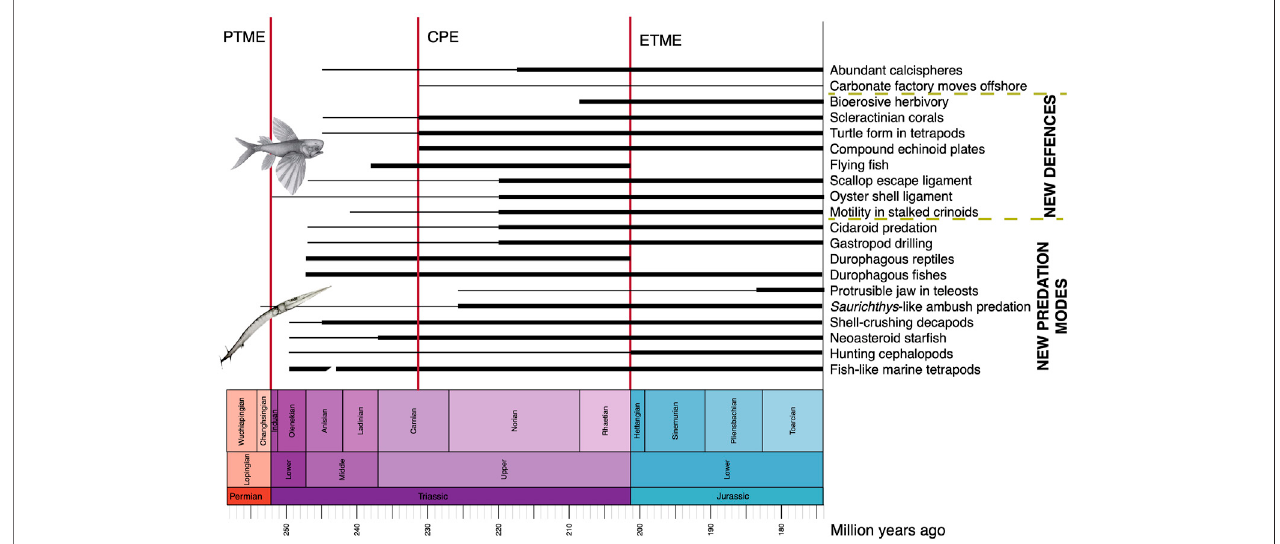
FIGURE 2 | Novel predatory and defensive modes in Triassic seas, showing approximate timings of known fossil records, or times when a phenomenon became established (thick line) and earlier occurrences, either inferred from phylogeny or based on rare fossils (thin line). The fl ying fi sh Potanichthys and the ambush-predatory Saurichthys are by Fei-xiang